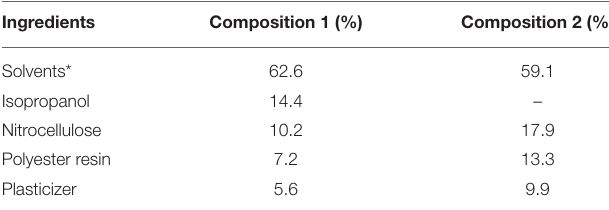
TABLE 1 | Compositions of colorless nail polishes.